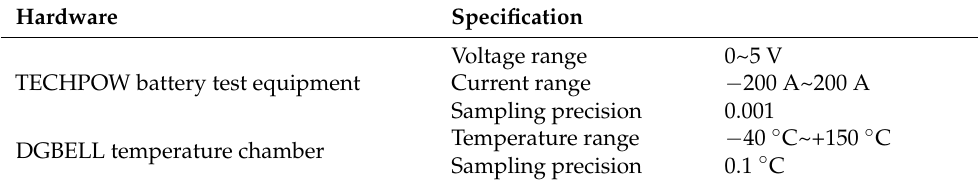
Figure 4. Battery testing platform. Table 2. The battery testing platform